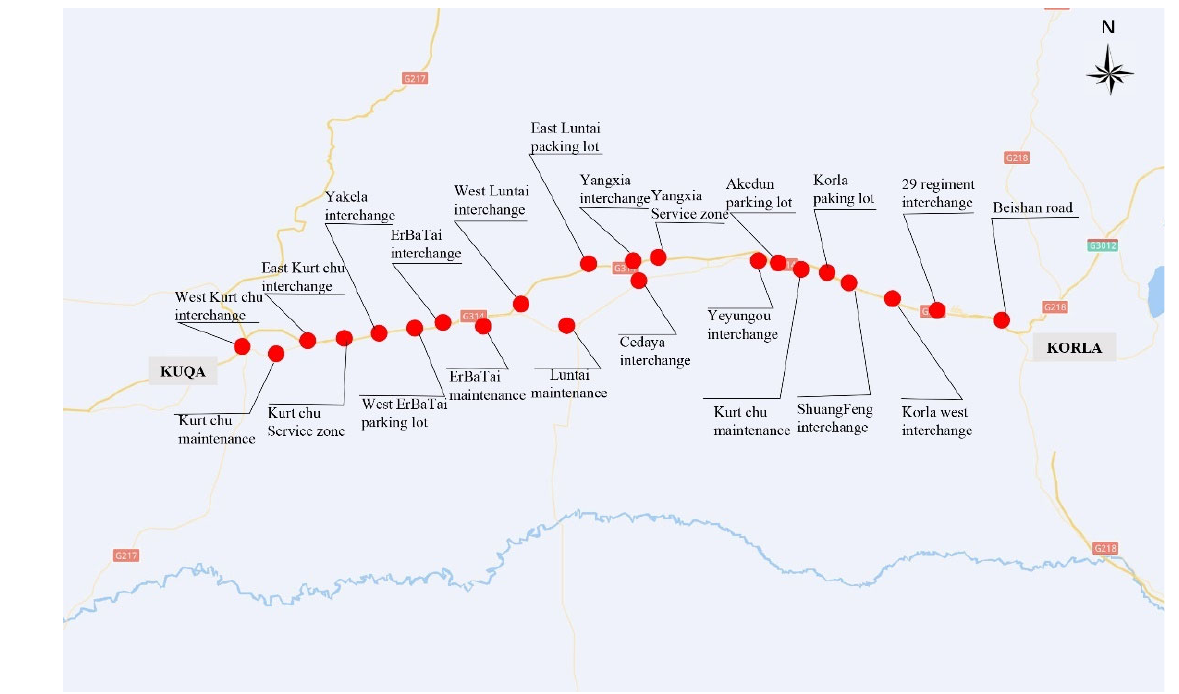
Figure 4. Regional sparse network in Aksu ‐ Korla.